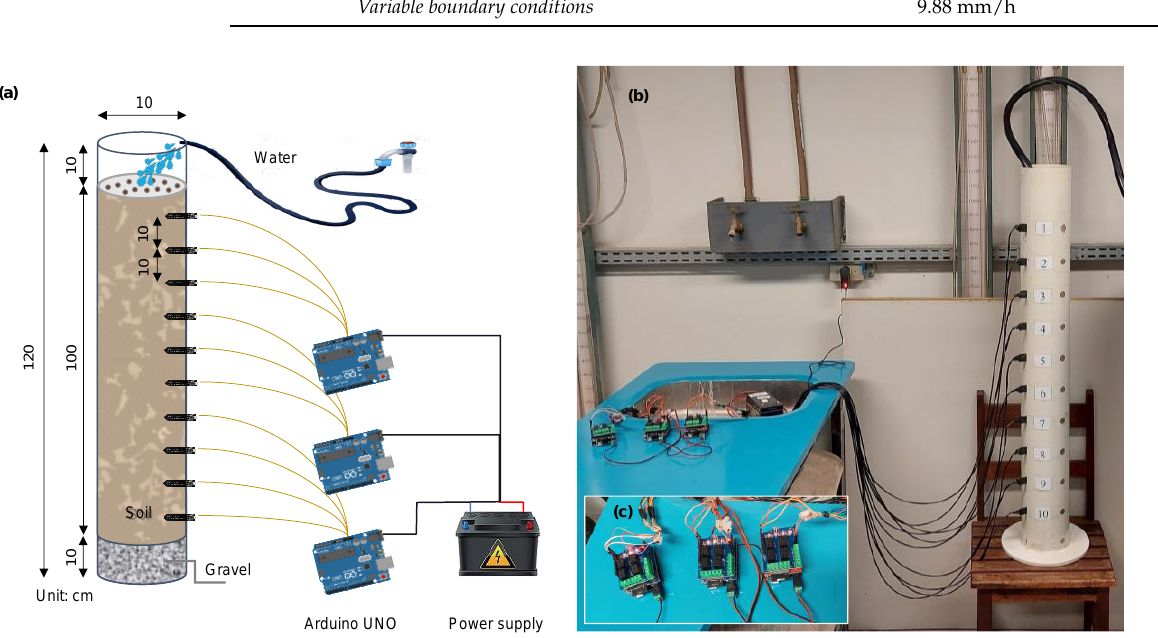
Figure 3. ( a ) Outline of column tests, ( b ) infiltration column, and ( c ) Arduino controllers and shields. Table 2. Input parameters of Hydrus-1D model.